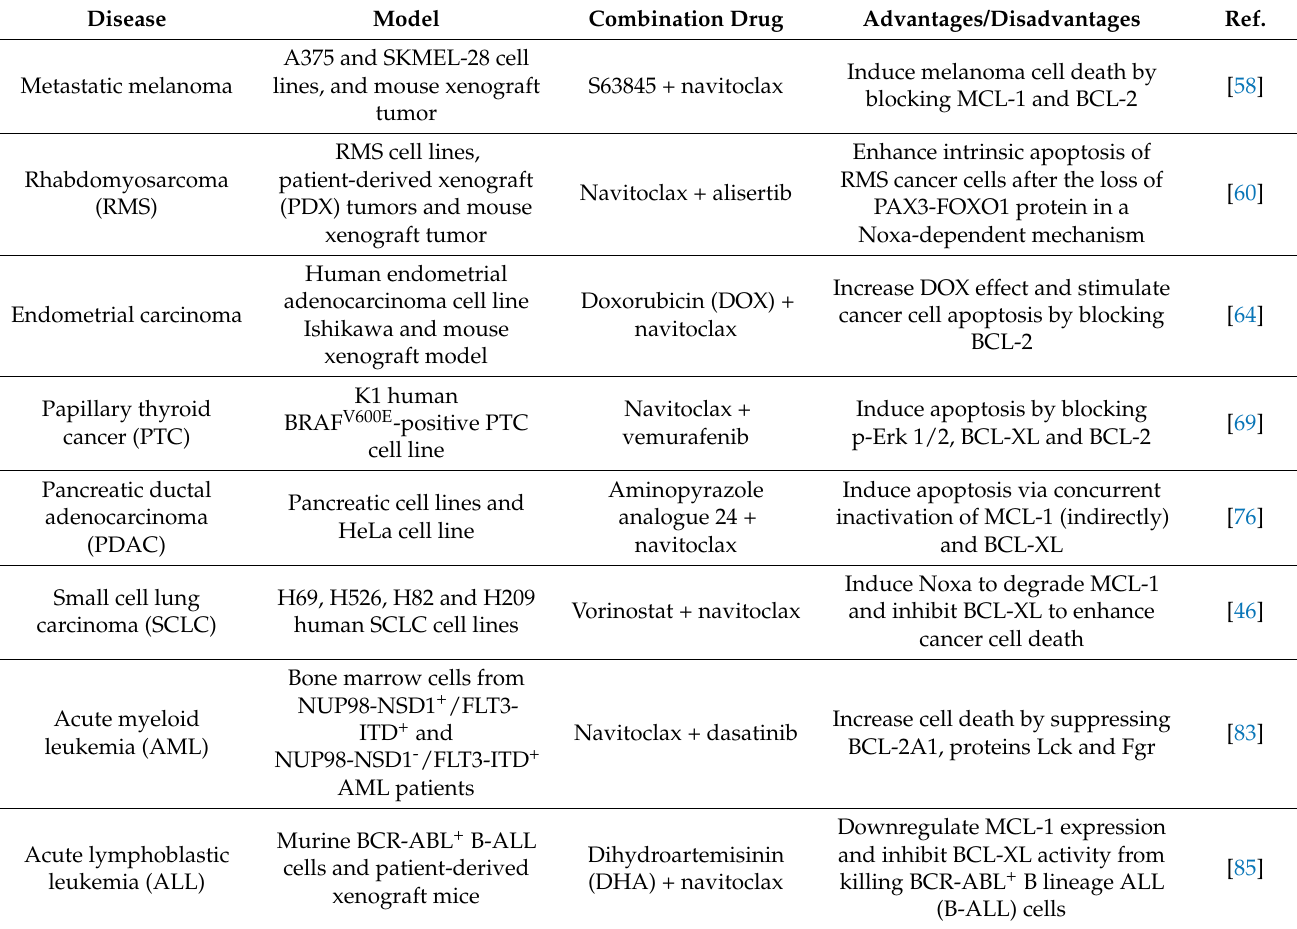
Table 1. Summary of navitoclax in combination with other